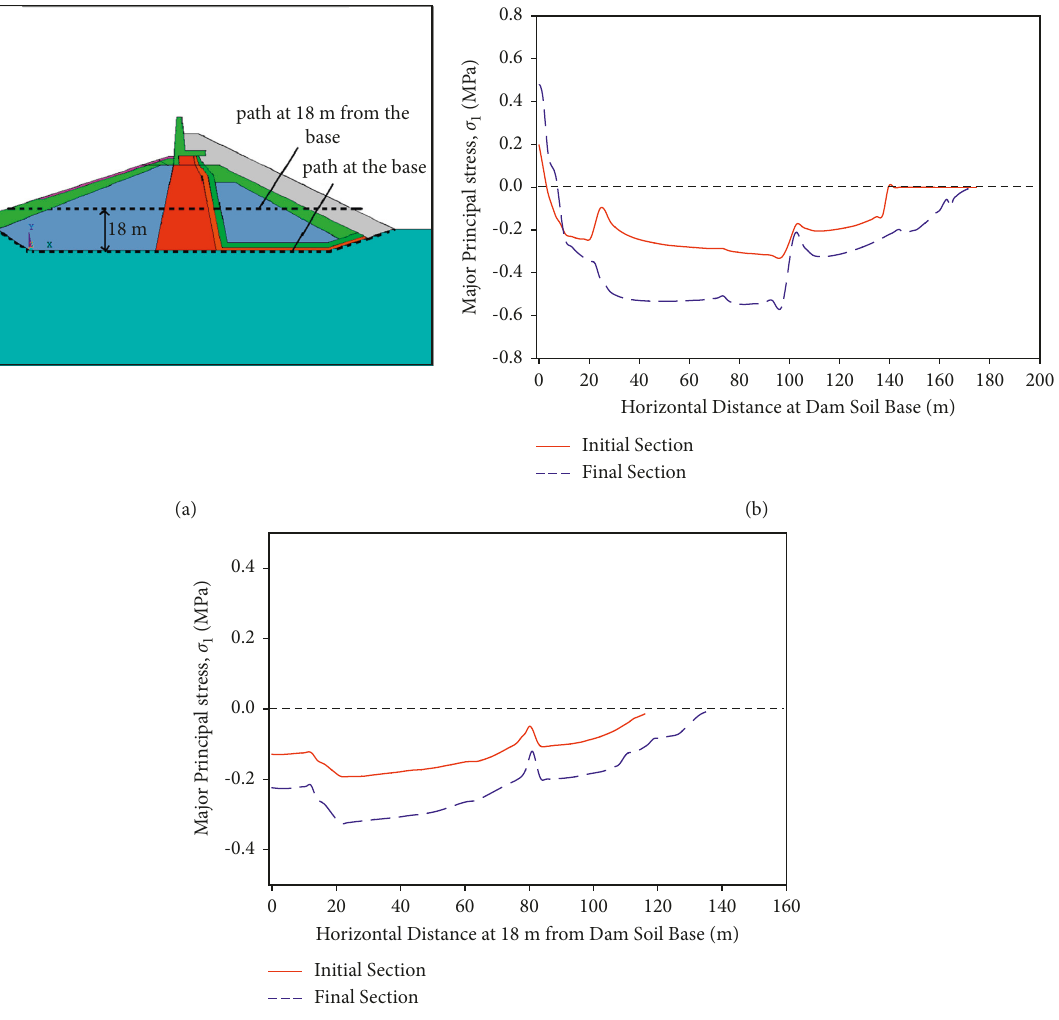
Figure 11: Maximum principal stress distribution as a function of radial distance: (a) location where stresses were taken, (b) for initial and final section at the dam foundation base and earthfill embankment, and (c) for initial and final section at 18 m from dam foundation and earthfill embankment